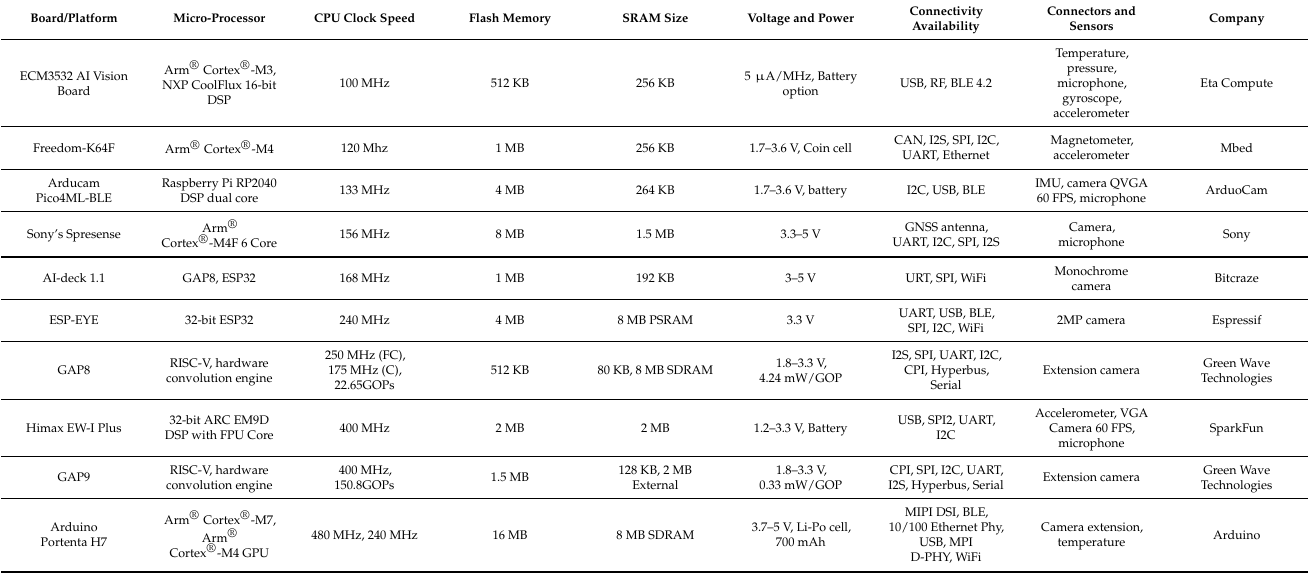
Table 3. Comparison of TinyML Supporting Hardware Platforms (CPU Clock ≥ 100